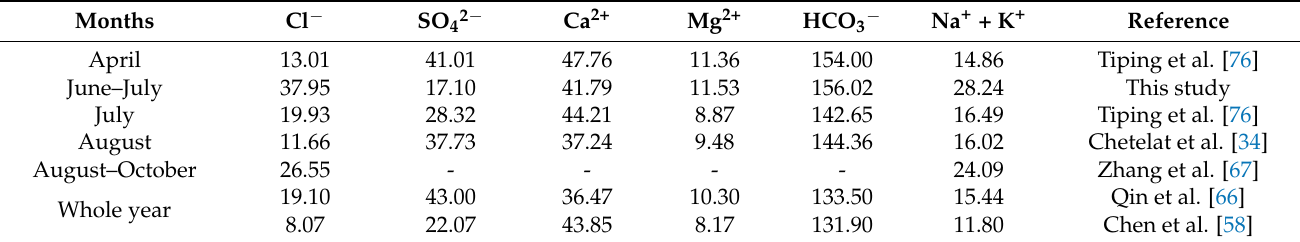
Table 2. Hydrochemical composition of the main stream in different months (the units of ions concentration were